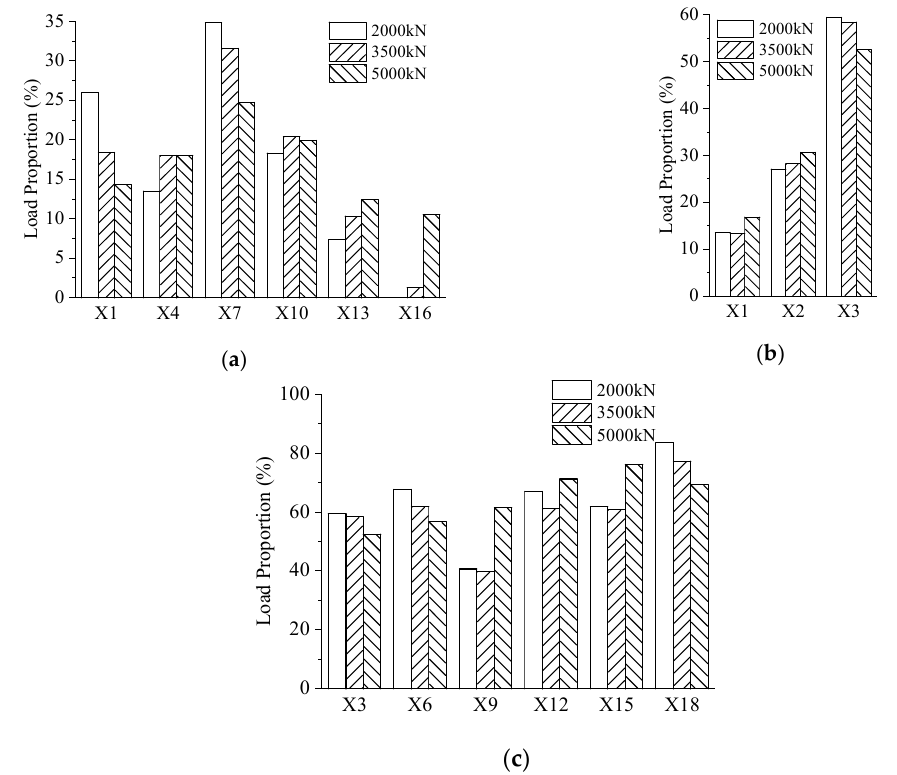
Figure 14. Load proportion of the PBL shear connectors: ( a ) X1 to X16 in the first row; ( b ) the first column; and ( c ) the load proportion of the strain gauges in the third row to their respective columns.